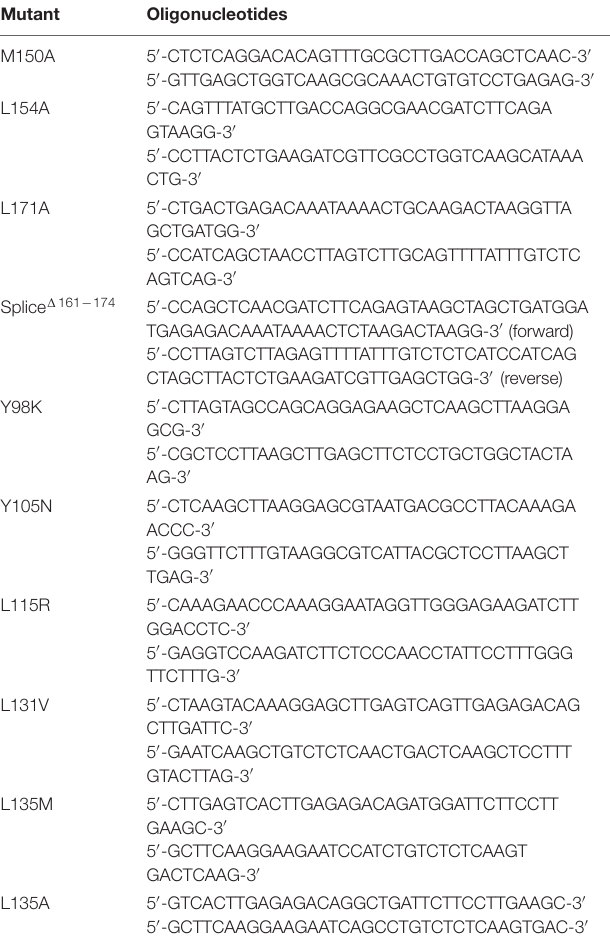
TABLE 1 | Oligonucleotides used for SEP3 ( 75 − 178 )